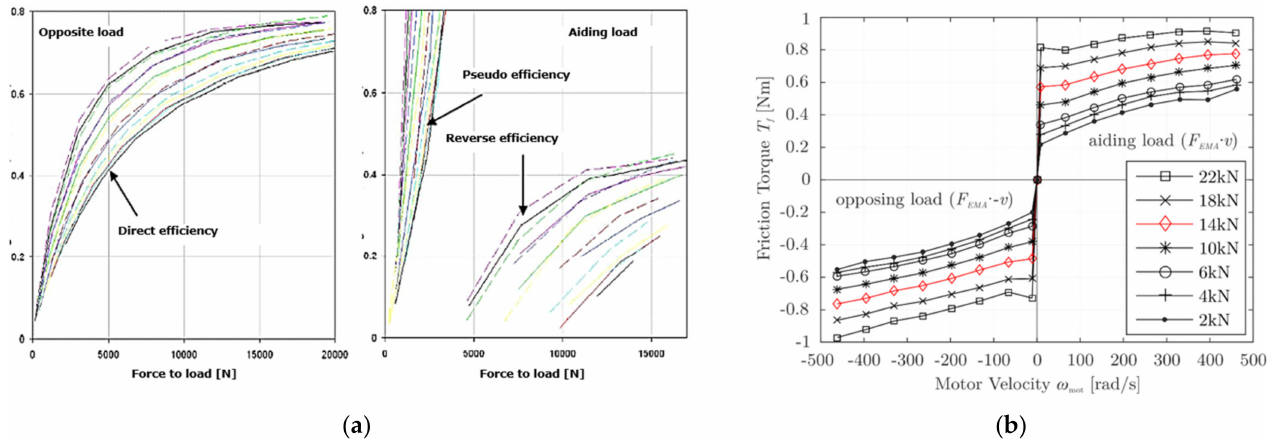
Figure 12. Examples of friction measurements in EMAs: ( a ) Ground test EMA, direct-drive linear actuator with roller screw, preloaded, rated force 50 kN [28]; ( b ) Demonstrator EMA sized for Airbus A320 aileron, gear-drive, ball-screw, no preload